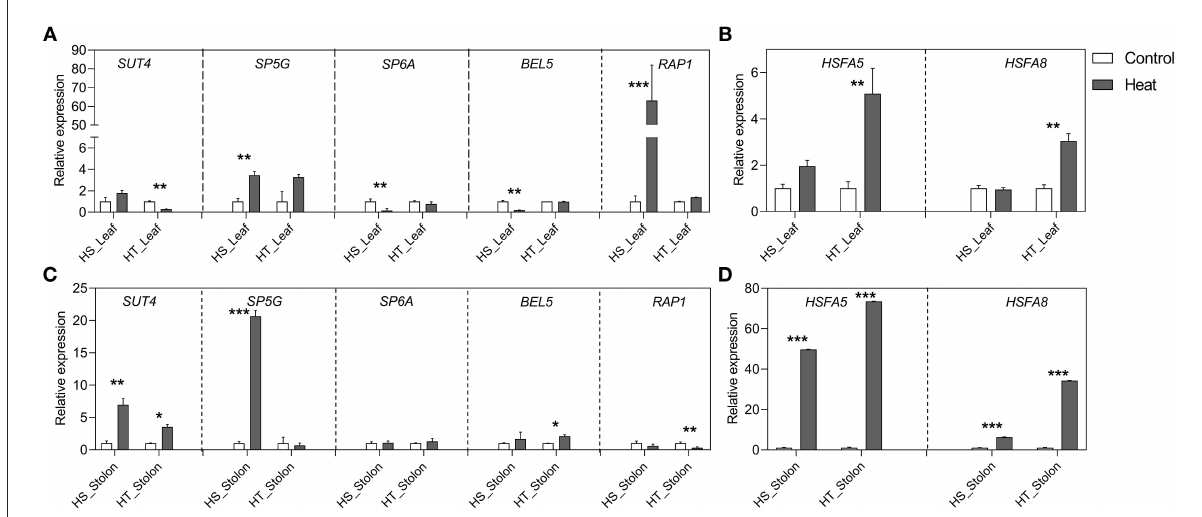
FIGURE7 Relative expression levels of potato tuberization genes and HSFs in leaf (A,B) and stolon (C,D) tissues in heat-sensitive (HS) and -tolerant (HT) genotypes under high-temperature stress. Three biological samples were measured with three technical replicates. The fold change in RNA levels was calculated as the 2– 11 Ct value relative to the mean values obtained in the leaf and stolon samples (set at a value of 1.0). Standard errors of the means are shown with one, two, and three asterisks indicating significant differences ( p < 0.05, p < 0.01, p < 0.001, respectively) using a Student’s t